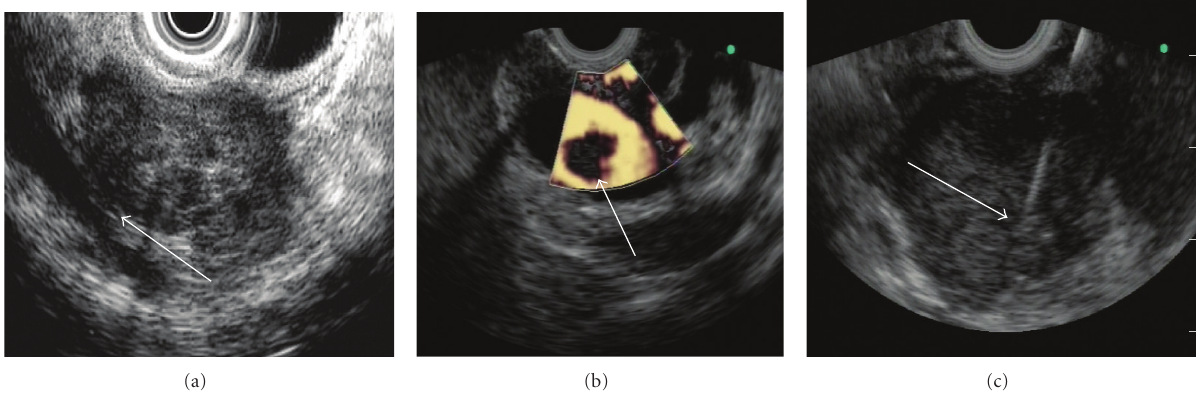
Figure 1: Images of endoscopic ultrasound in advanced pancreatic cancer: (a) tumor invading the vasculature, (b) portal vein thrombosis in advanced pancreatic cancer, (c) fine-needle aspiration biopsy of the pancreatic tumor.